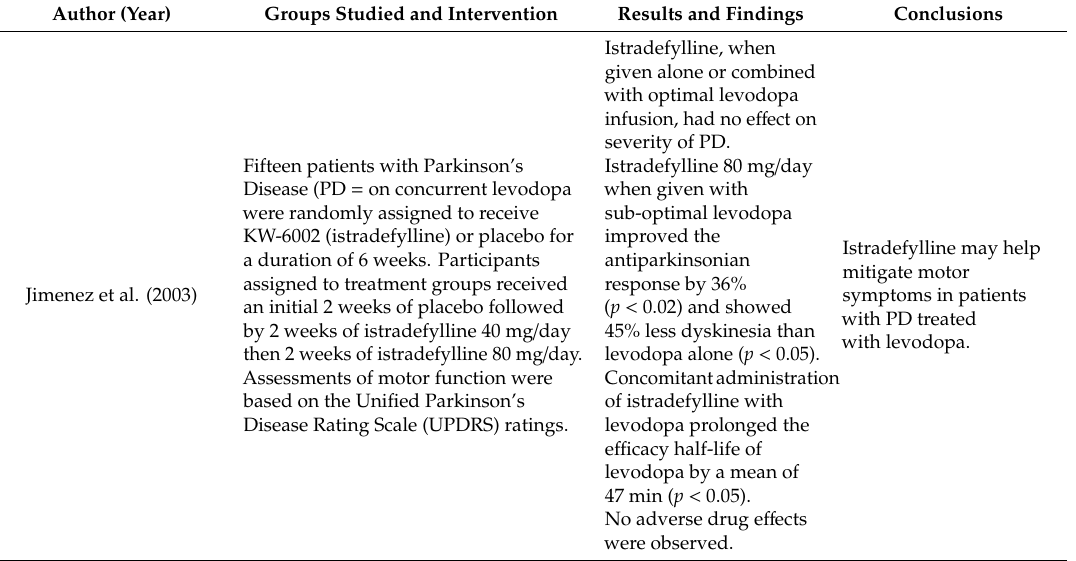
Table 1. Clinical E ffi cacy and